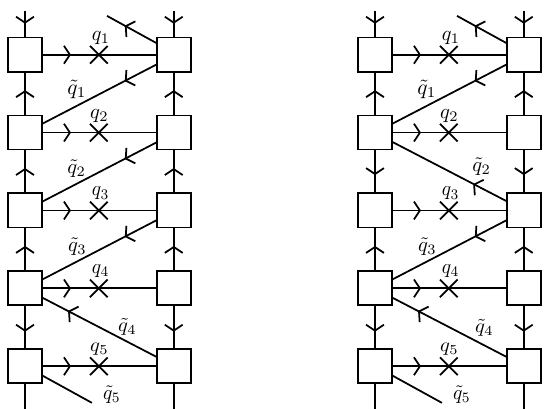
Figure 2 . Quiver diagrams for the domain walls in the A 4 quiver gauge theory. The domain wall on the left is for the boundary condition B = f + ; + ; + ; (cid:0) ; (cid:0)g and the domain wall on the right is for B = f + ; (cid:0) ; + ; (cid:0) ; (cid:0)g . The square boxes denote the SU( N ) 5 (cid:2) SU( N ) 0 5 gauge symmetries of 5d gauge theories on both sides of the walls. The symbol (cid:2) denotes (cid:13)ip (cid:12)elds coupled to the baryonic operator made from q i